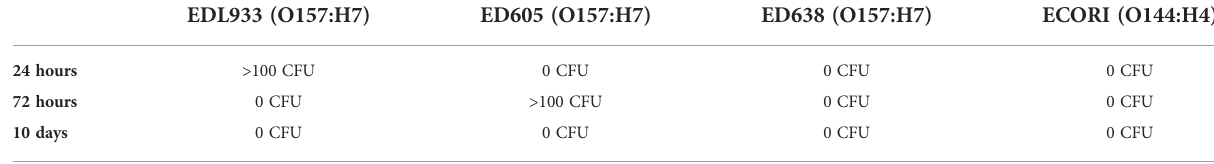
TABLE 3 E. coli (CFU) intracellular of Acanthamoeba sp. at 24 hours, 72 hours and 10 days (short time intracellular